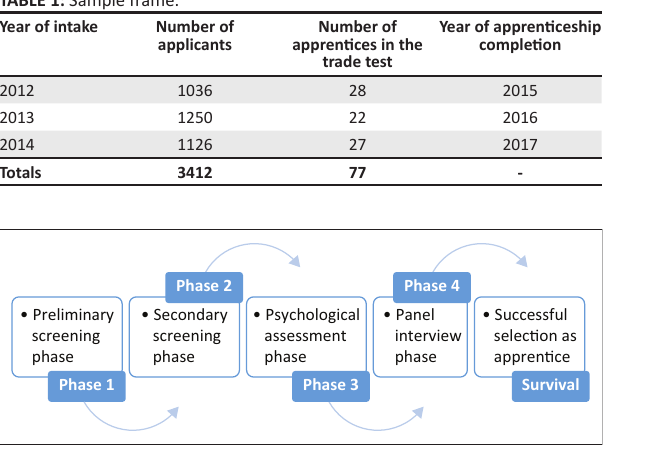
FIGURE 1: The selection phases.